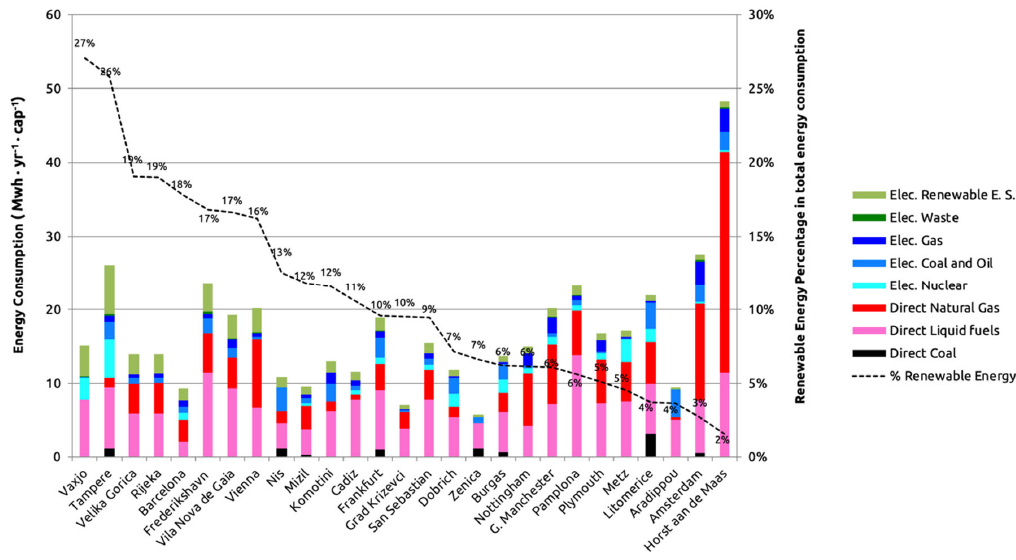
Figure 5. Energy consumption by fuel within the direct and indirect (in electric vector) energy consumptions by municipality (note that the total consumption of cities obtained from mPOWER survey differs, as shown in Figure 3, from the national average data provided by International Energy Agency (IEA)).